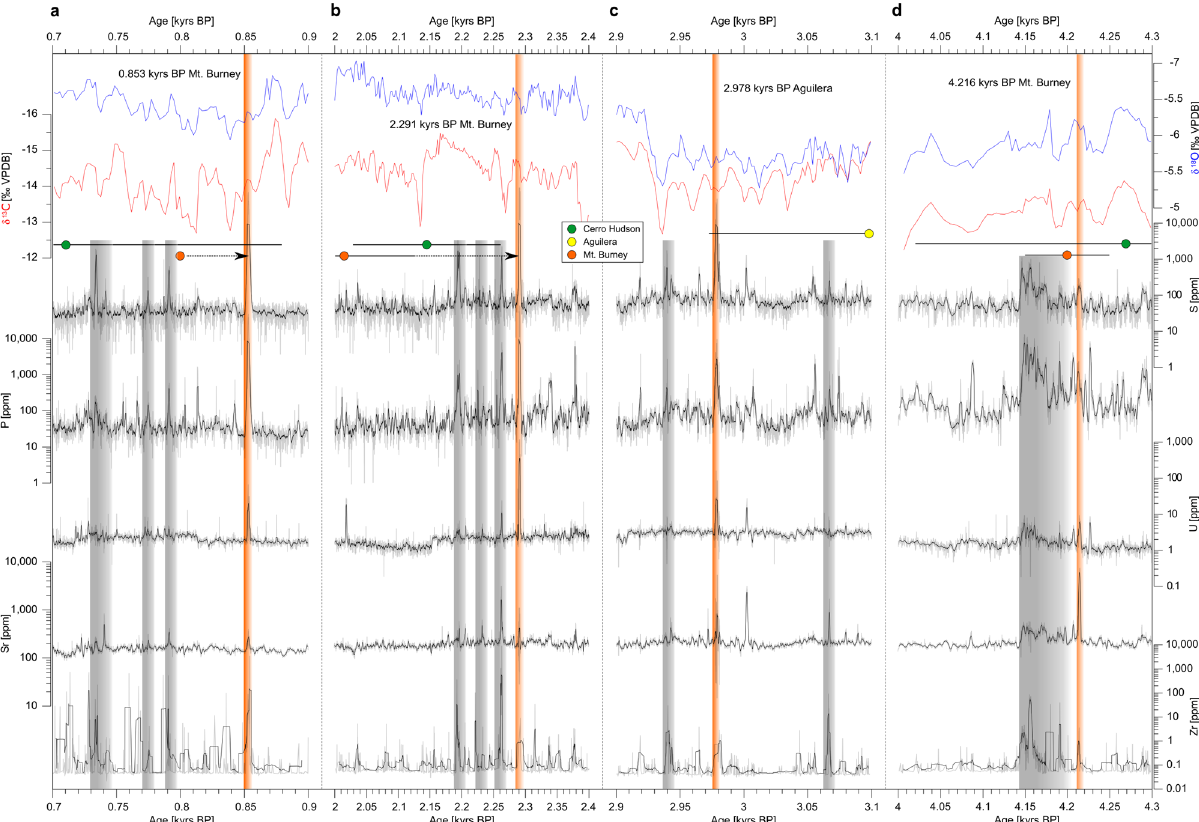
Fig. 4 Stable isotope and LA-ICP-MS data of MA1 for time spans enclosing eruptions of Mt. Burney and Aguilera volcanoes. a – d δ 18 O and δ 13 C records 25 of stalagmite MA1 combined with concentrations of S, P, U, Sr, and Zr ( a 0.9 – 0.7 kyrs BP; b 2.4 – 2.0 kyrs BP; c 3.1 – 2.9 kyrs BP; d 4.3 – 4.0 kyrs BP). 14 C-ages of tephra layers from Late Holocene eruptions of Cerro Hudson, Aguilera, and Mt. Burney 3 are indicated. Orange bars highlight times with compositional trace element peaks at 4.216, 2.978, 2.291, and 0.853 kyrs BP. Gray bars mark time spans characterized by elevated incorporation of micrometer-scale detrital volcanic glass mobilized during storm